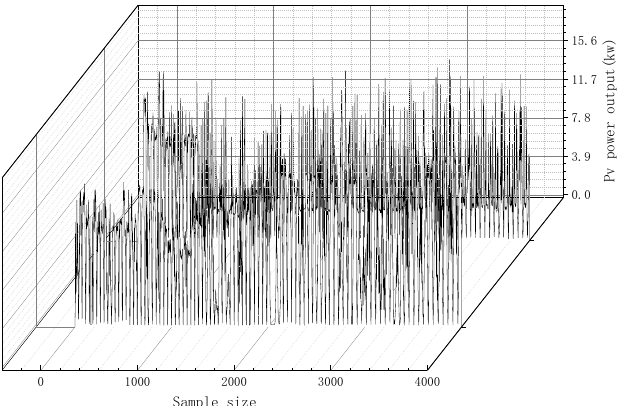
Figure 8. Schematic diagram for data set division.